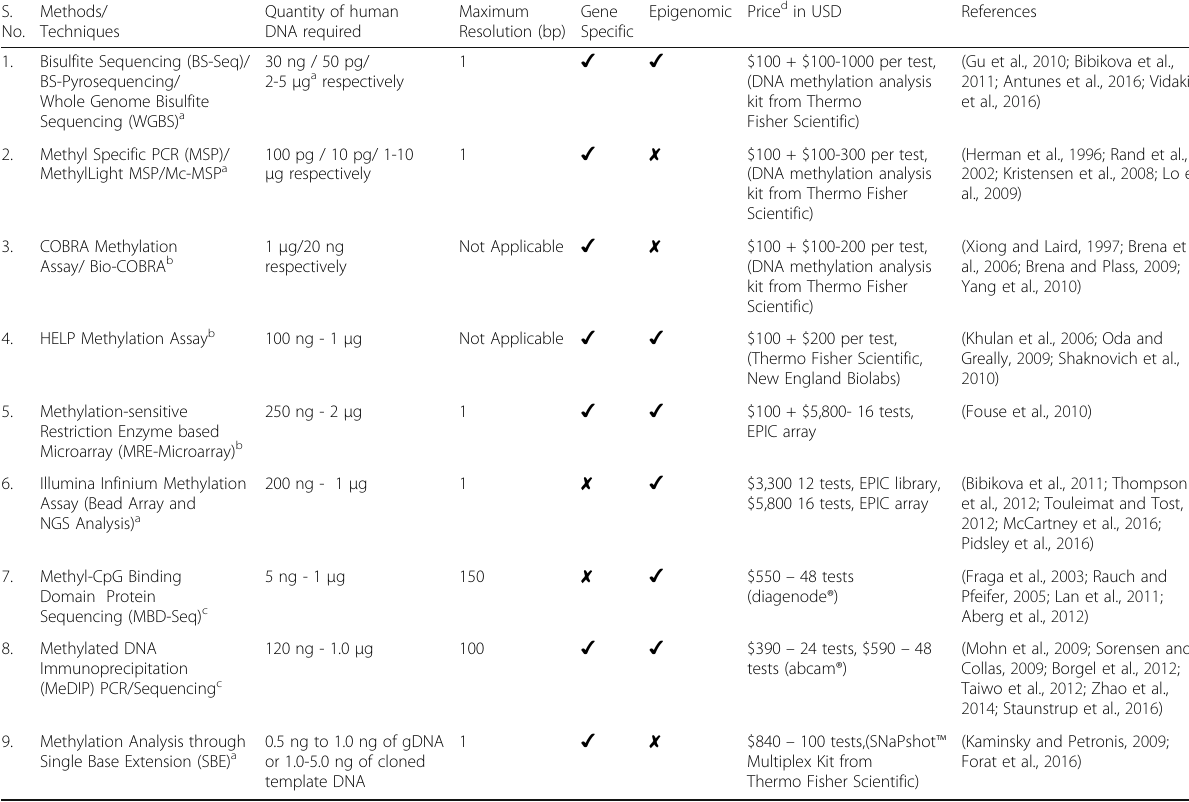
Table 1 Methods/techniques for detecting/analysis of Differential DNA